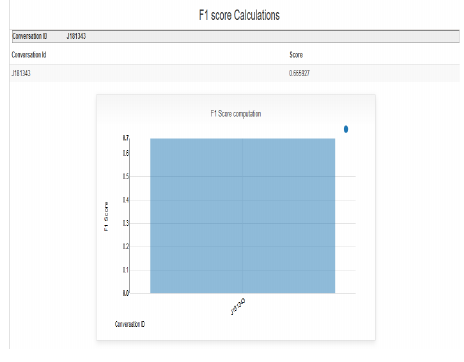
Figure 27. F1-score represented in a tabular and graphical